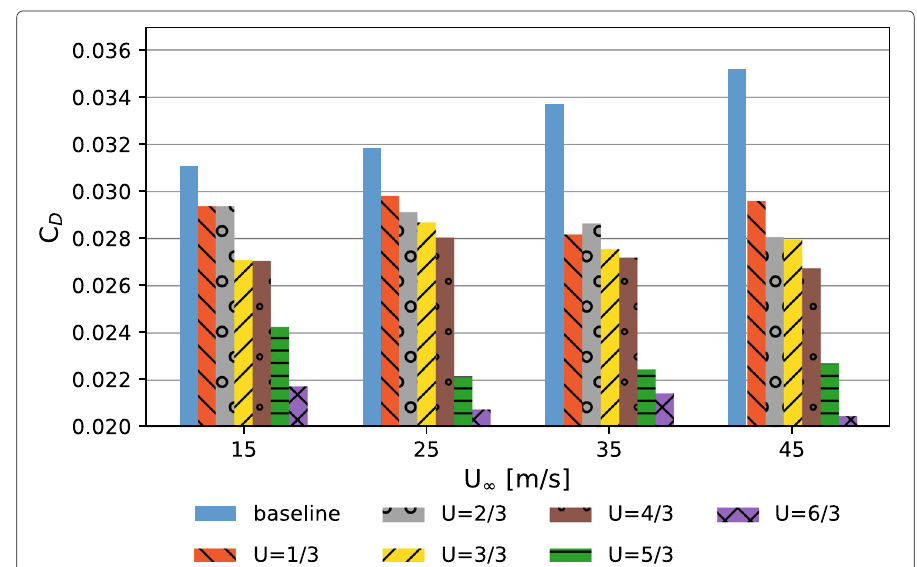
Fig. 13 Time-averaged drag coefficient for the front wheels only with 90 ◦ air-jet wheel deflectors